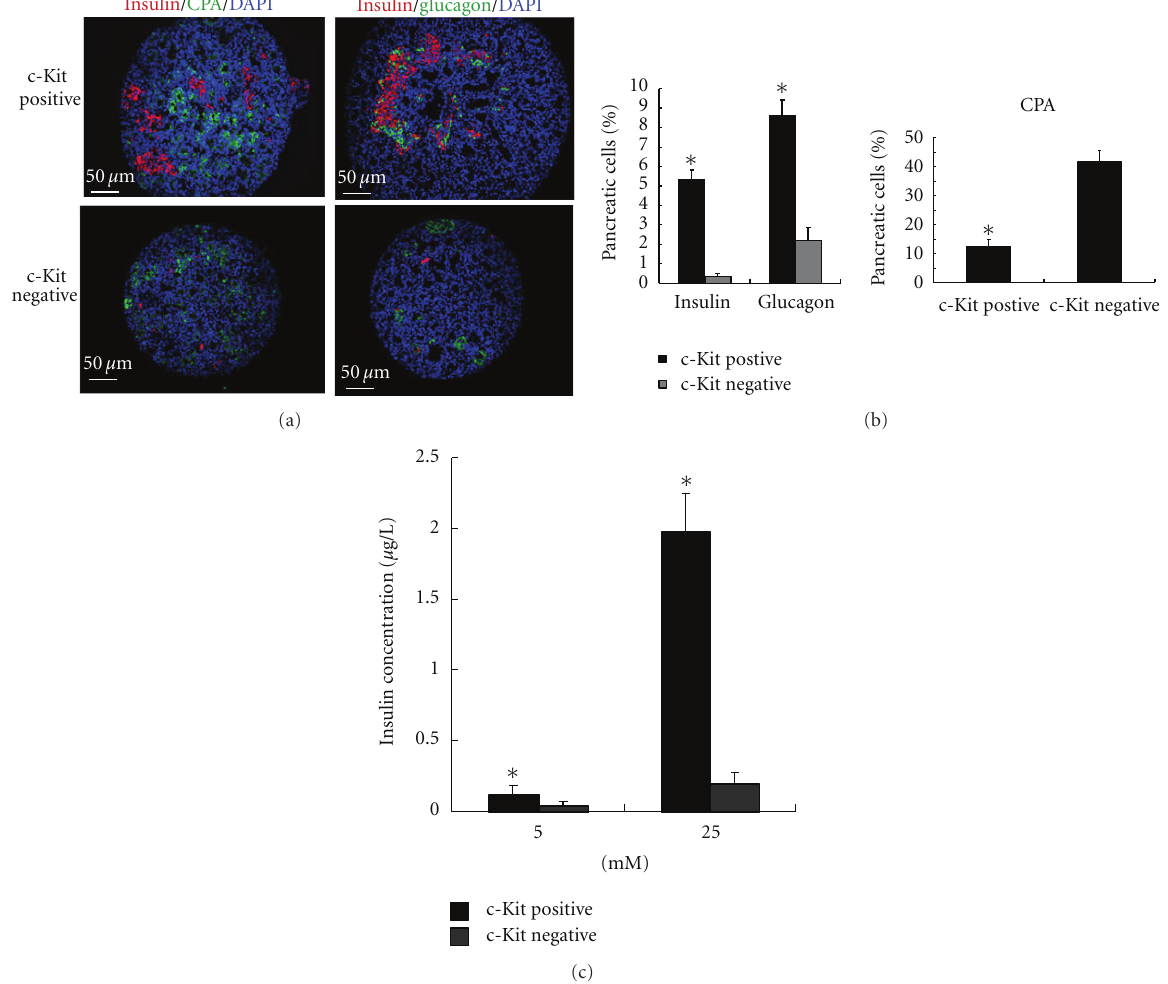
Figure 5: The comparison of spheres di ff erentiated from c-Kit-positive and-negative cells. (a) Immunohistological staining of insulin, glucagon, and CPA in spheres. (b) Quantitative analysis of insulin and glucagon expression in spheres. ∗ P < 0 . 05 versus c-Kit-negative cells. (c) Quantitative analysis of CPA expression in spheres. ∗ P < 0 . 05 versus c-Kit-negative cells. (d) Insulin secretion in response to 5mM and 25 mM glucose in spheres. ∗ P < 0 . 05 versus c-Kit-negative